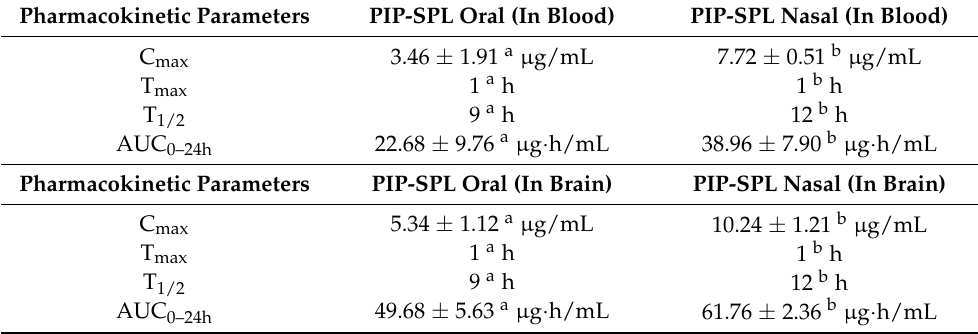
Figure 9. Drug concentration profiles of piperine in brain after oral and intranasal delivery. *: Statistically significant at p ≤ 0.01. Table 4. Pharmacokinetic